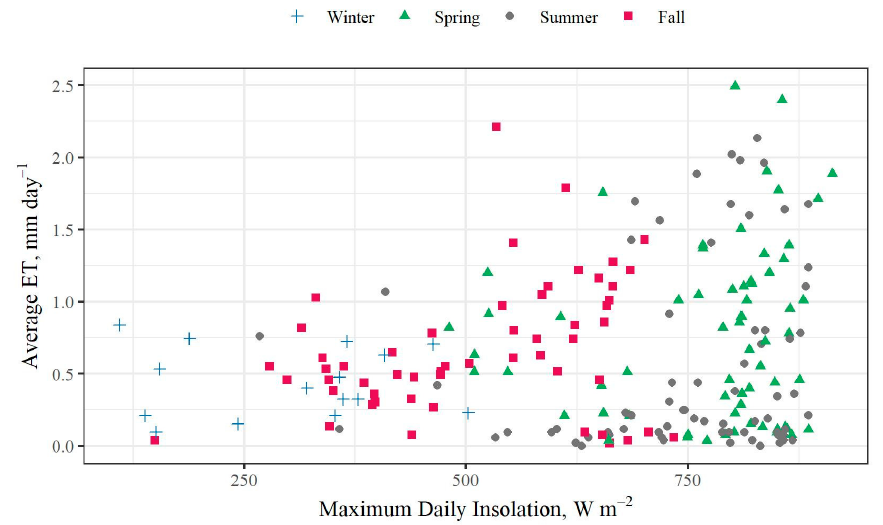
Figure 9. Seasonal trends in average daily evapotranspiration relative to maximum daily insolation on the OnCenter green roof.